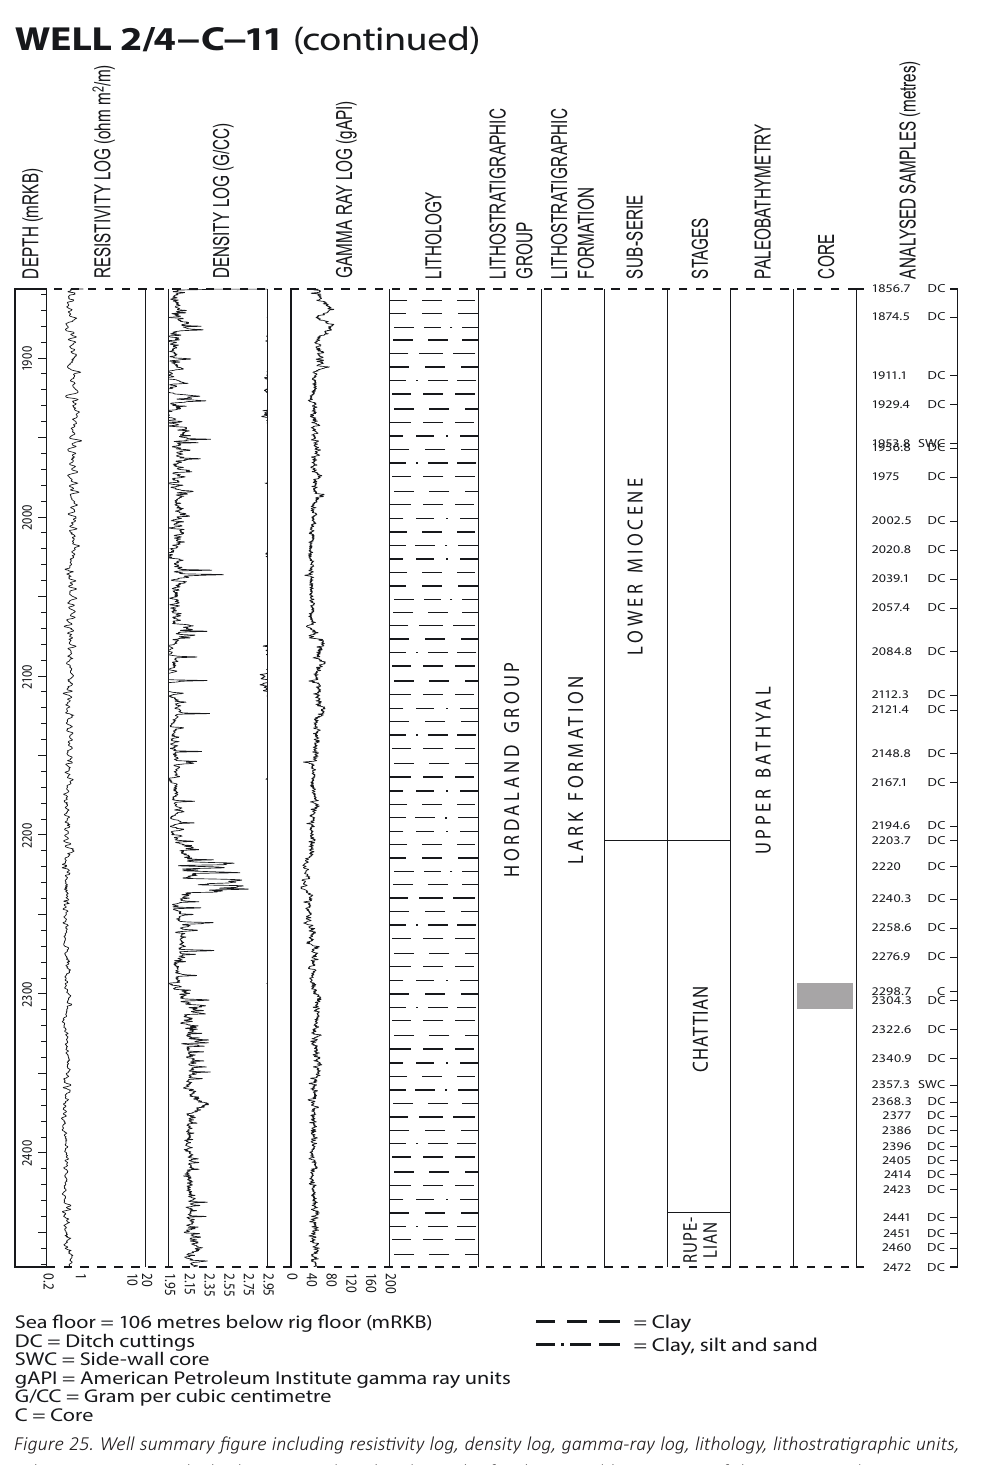
Figure 25. Well summary figure including resistivity log, density log, gamma-ray log, lithology, lithostratigraphic units, sub-series, stages, paleobathymetry and analysed samples for the second-bottom part of the investigated sequence in well 2/4–C–11 (Rupelian (upper part) to lower Miocene) including the supplementary well reference section for the Lark Formation (middle part; modified after Eidvin et al., 1999,